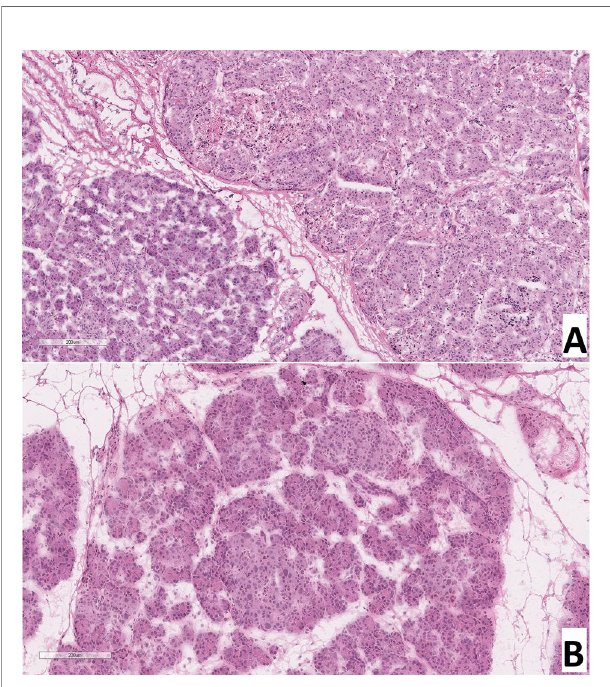
FIGURE 3 | Frozen pancreatic sections. (A) – focal form of congenital hyperinsulinism (patient 5), zone of adenomatous hyperplasia with enlarged nuclei of endocrinocytes (right) and normal pancreatic tissue (left). (B) – diffuse form of congenital hyperinsulinism (patient 20), enlarged nuclei of endocrinocytes in pancreatic islets. Hematoxylin and eosin